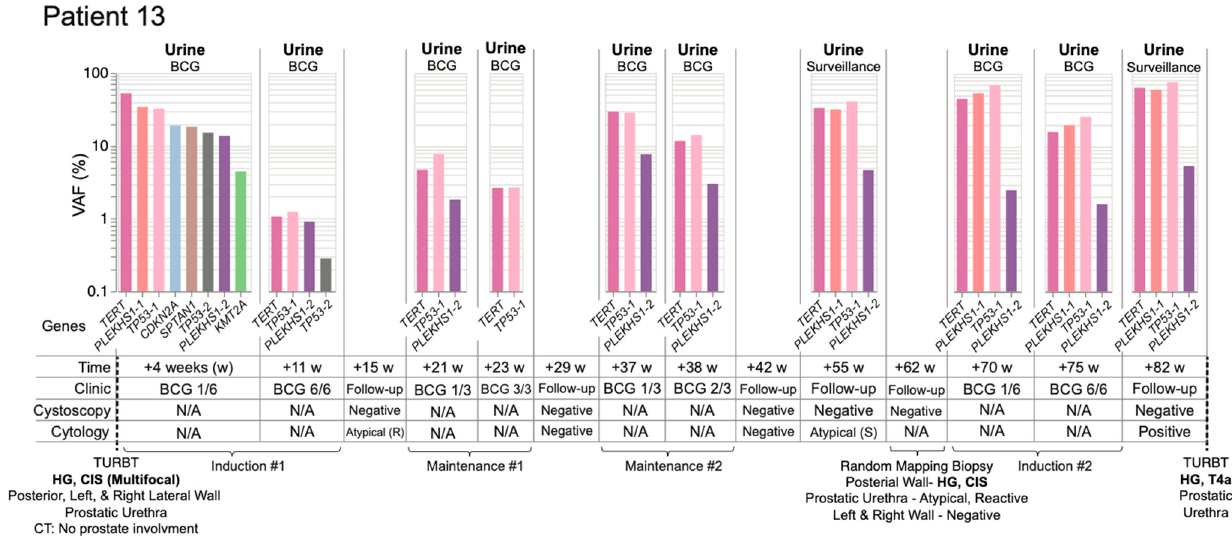
Figure 8. UroAmplitude predicts persistent disease and invasive progression with a 20-month lead-time. Longitudinal mutation profiles in urine samples taken over the course of BCG instilla- tion. Mutations are grouped chronologically to demonstrate genomic changes over the course of treatment. Tumor mutations are color-coded to allow surveillance across longitudinal collections. Patient 13 surveillance begins at the time of first BCG instillation and continues for 1 year and 7 months. Disease recurrence with invasive progression occurs 20 months from initial TUR. Four intervening time-points for surveillance cystoscopy/cytology are included without corresponding UroAmplitude testing. Atypical cytology results are noted as reactive (R) or suspicious (S). Low frequency (<1.0%), nonrecurring mutations are withheld in the interest of space and clarity. Maintenance BCG began at 21 weeks. UroAmplitude showed an increase in